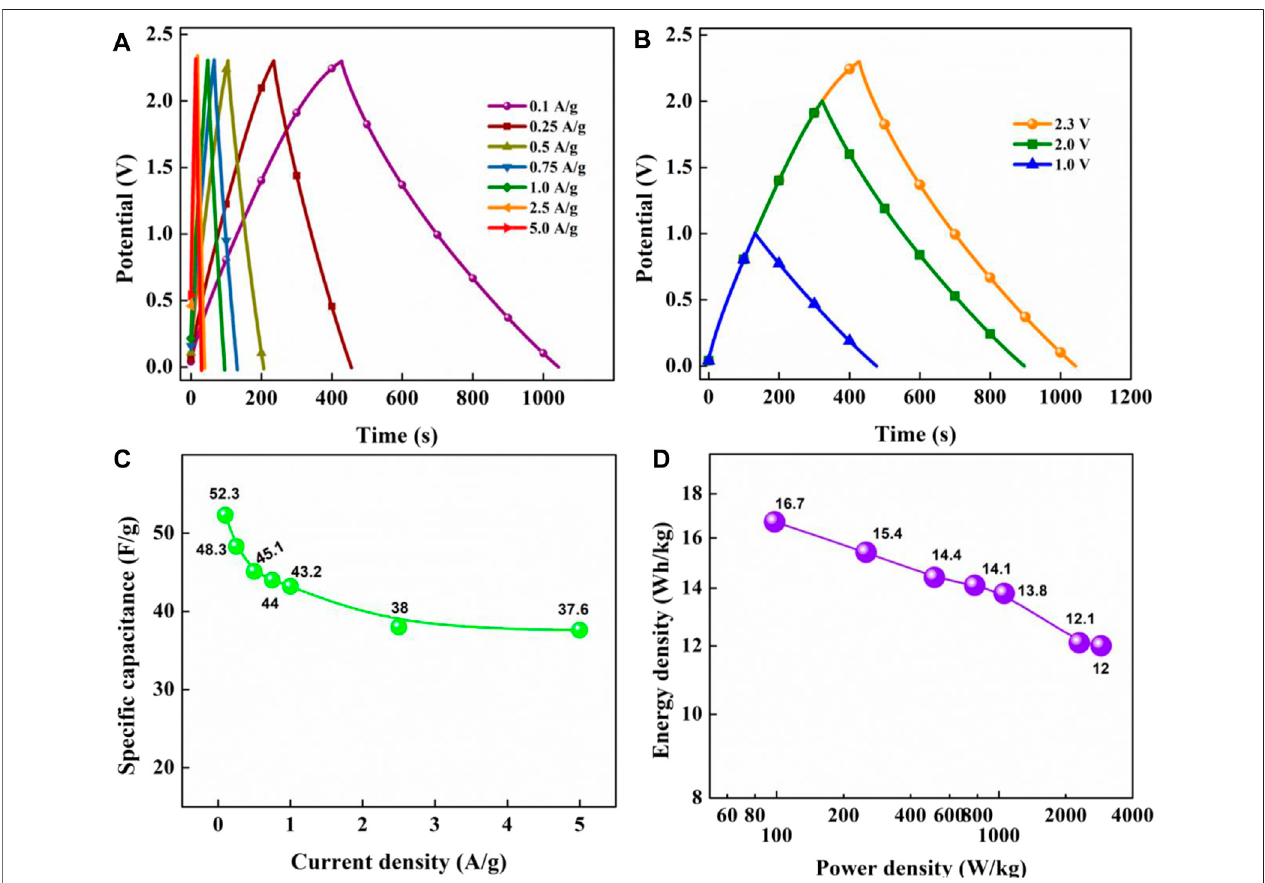
FIGURE9| GCDcurvesatvariouscurrentdensitiesat2.3 V (A) ,comparativeGCDcurvesat0.1 A/gunderdifferentoperatingvoltages (B) ,speci fi ccapacitanceas a function of current density (C) , and Ragone plot at 2.3 V (D) .